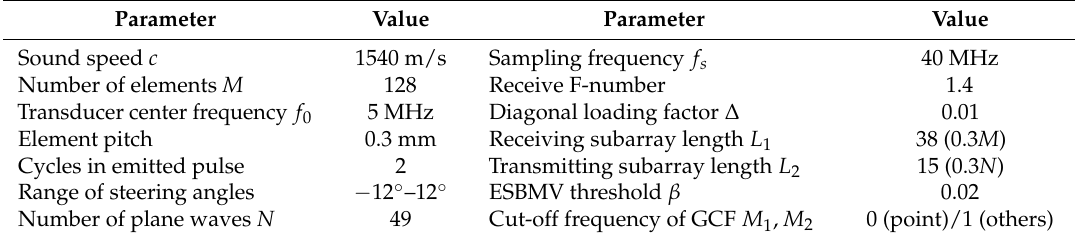
Table 1. Transducer and processing